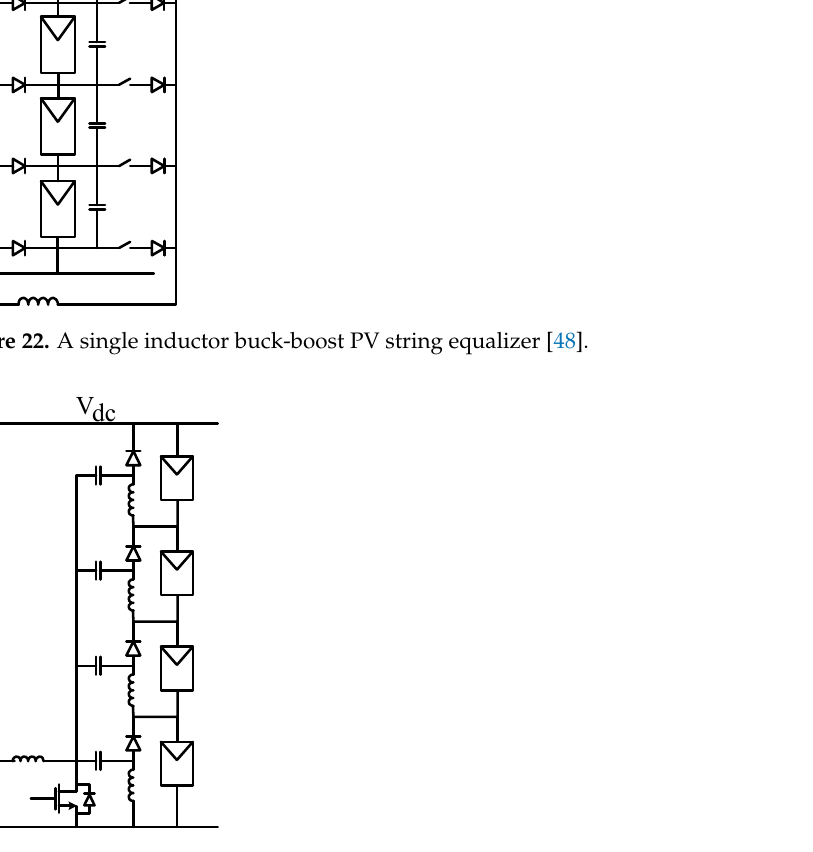
Figure 23. Single switch multi-stack SEPIC voltage equalizer [52].